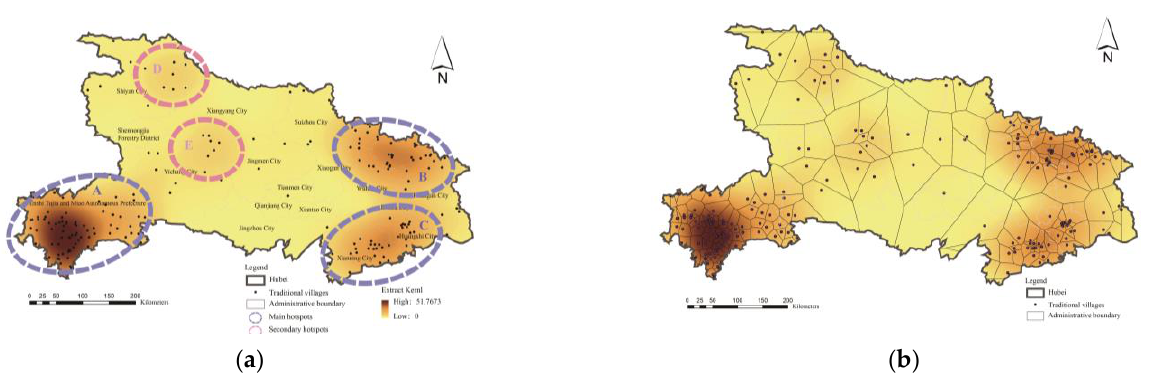
Figure 3. ( a ) Kernel density distribution of traditional villages; ( b ) Voronoi diagram of traditional villages.